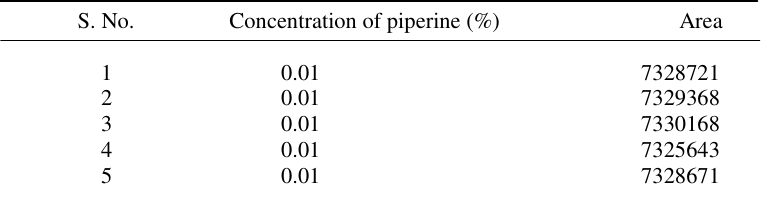
Table 2. Determination of standard deviation and coefficient of variation for standard piperine